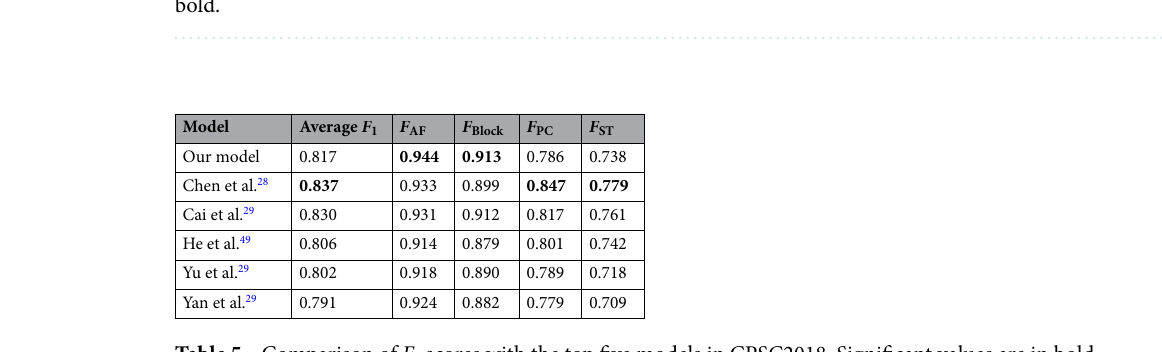
Table 4. Other performance metrics of the DSE-ResNet on CPSC2018 hidden test set. Significant values are in bold.